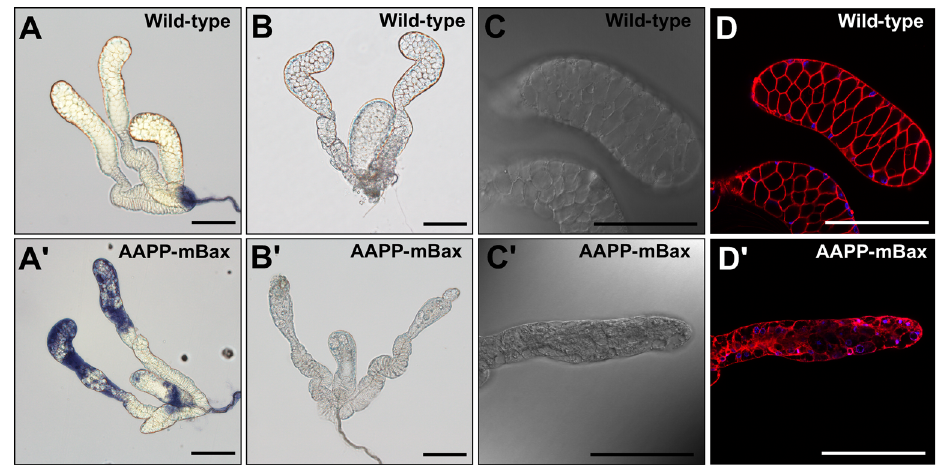
7-day-old adult female wild-type mosquito. (B ’ ) An abnormal salivary gland with aberrant distal-lateral lobes from a 7-day-old adult female AAPP-mBax mosquito (line 1). (C, C ’ ) Differential interference contrast